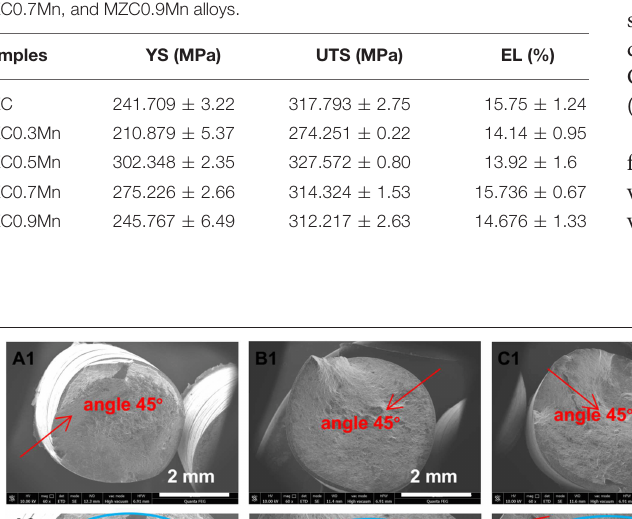
Figure 10 indicates that the MZC0.3Mn, MZC0.5Mn, MZC0.7Mn, and MZC0.9Mn alloys have a longer yield plateau compared to the MZC alloy, which means that a more dense passivation film is formed on the surface of the alloys with Mn than the surface of the control when the sample is